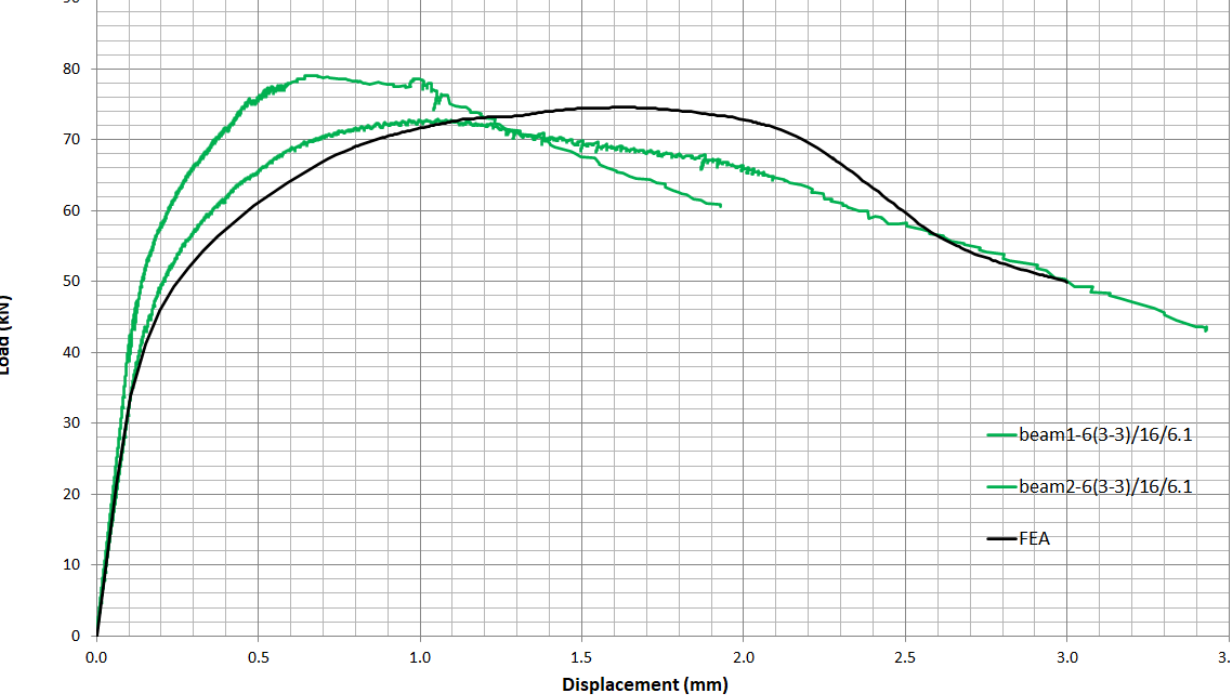
Figure 20. Comparison of load–displacement curves in indirect tension from experimental data and FEA.